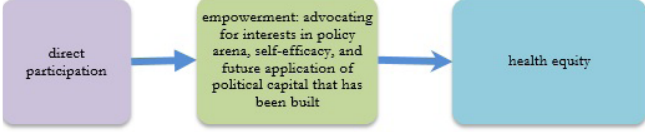
Figure 2: Presumed pathway from participation to health